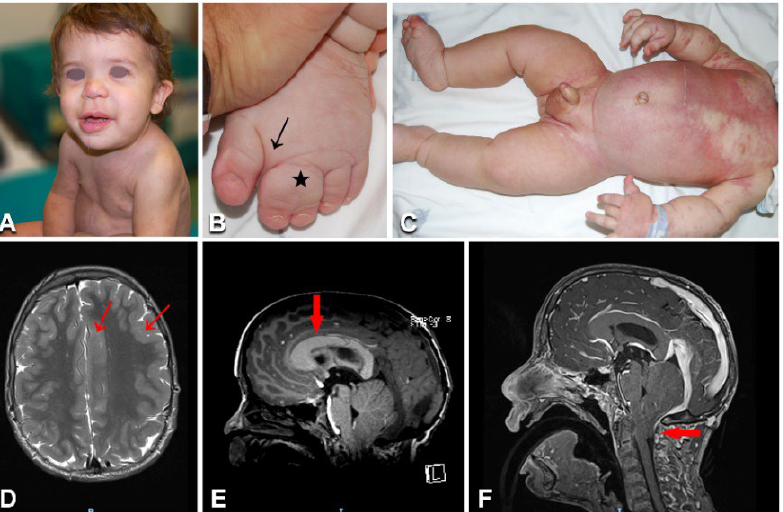
Figure 4. Clinical and imaging features in a toddler with megalencephaly–capillary malformation– polymicrogyria syndrome: ( A ) Diffuse partly reticulate capillary malformation on the trunk, limbs, and nose in patient n. 25 at the age of 17 months ( A , C ); the toddler also presents macrocephaly ( A ), along with left face and upper and lower limb hypertrophy ( A , C ), as well as sandal gap and syndactyly of left toes 2-3 (arrow and asterisk in B ). Brain MRI shows left hemimegalencephaly ( D ), polymicrogyria (arrows in D ), thick corpus callosum (arrow in E ), and Chiari malformation type I with herniation of the cerebellar tonsils through the foramen magnum (arrow in F ).